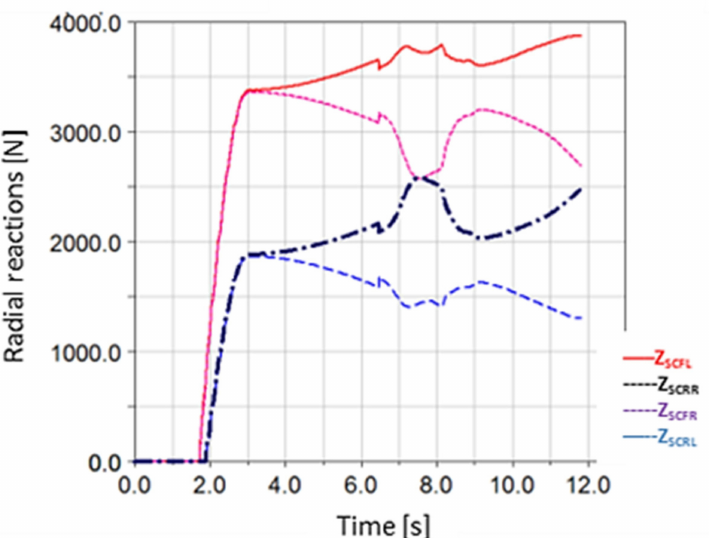
Figure 4. The course of the radial reactions of the ASC wheels when tilting on the tilting platform and 80% unweight of the vehicle wheels. ( Z SCFL —radial reaction of the support front left wheel (N); Z SCFR —radial reaction of the support front right wheel (N); Z SCRL —radial reaction of the supporting rear left wheel (N); and Z SCRR —radial reaction of the supporting rear right